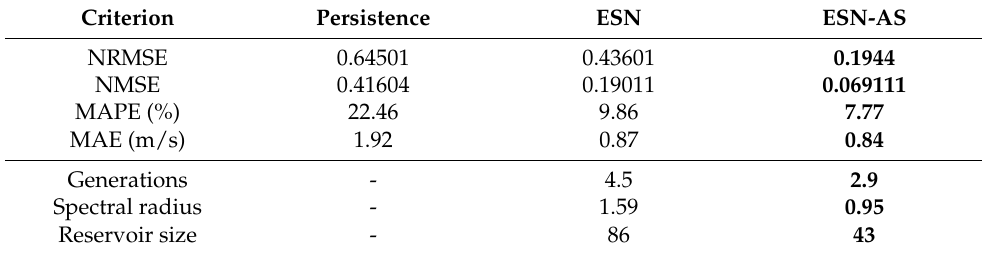
Table 3. Average test performance—TRI.